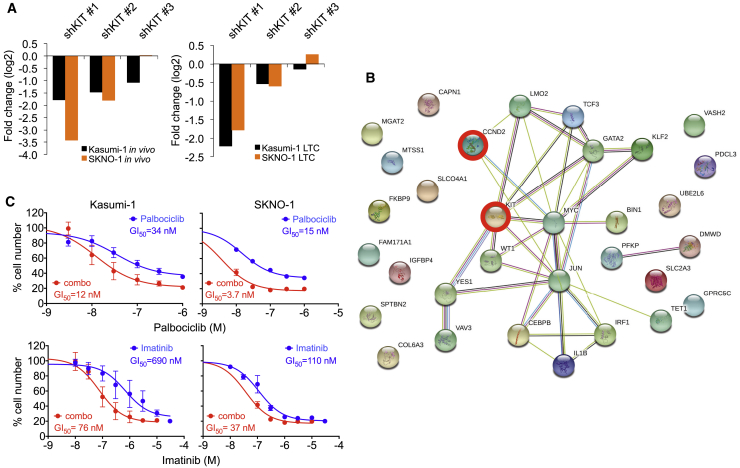
CDK4/6 Interference Sensitizes AML Cells toward Inhibition of Mutated KIT(A) Fold change of all KIT shRNA constructs in RNAi screens after third replatings (top) and in vivo engraftment (bottom) in t(8;21) cell lines.(B) String-generated gene network showing interactions between genes indicated by the in vivo RNAi screen. Nodes represent genes indicated by at least two shRNAs in combined SKNO-1 and Kasumi-1 screens.(C) Dose-response curves for proliferation of Kasumi-1 and SKNO-1 cells with palbociclib, imatinib (blue curves), or a combination with a fixed molar ratio of palboclib:imatinib of 1:10 (red curves). Top and bottom x axes show the corresponding palbociclib and imatinib concentrations. Cell numbers were counted after 72 hr of drug treatment. Mean ± SD; n = 4.See also Figure S8.